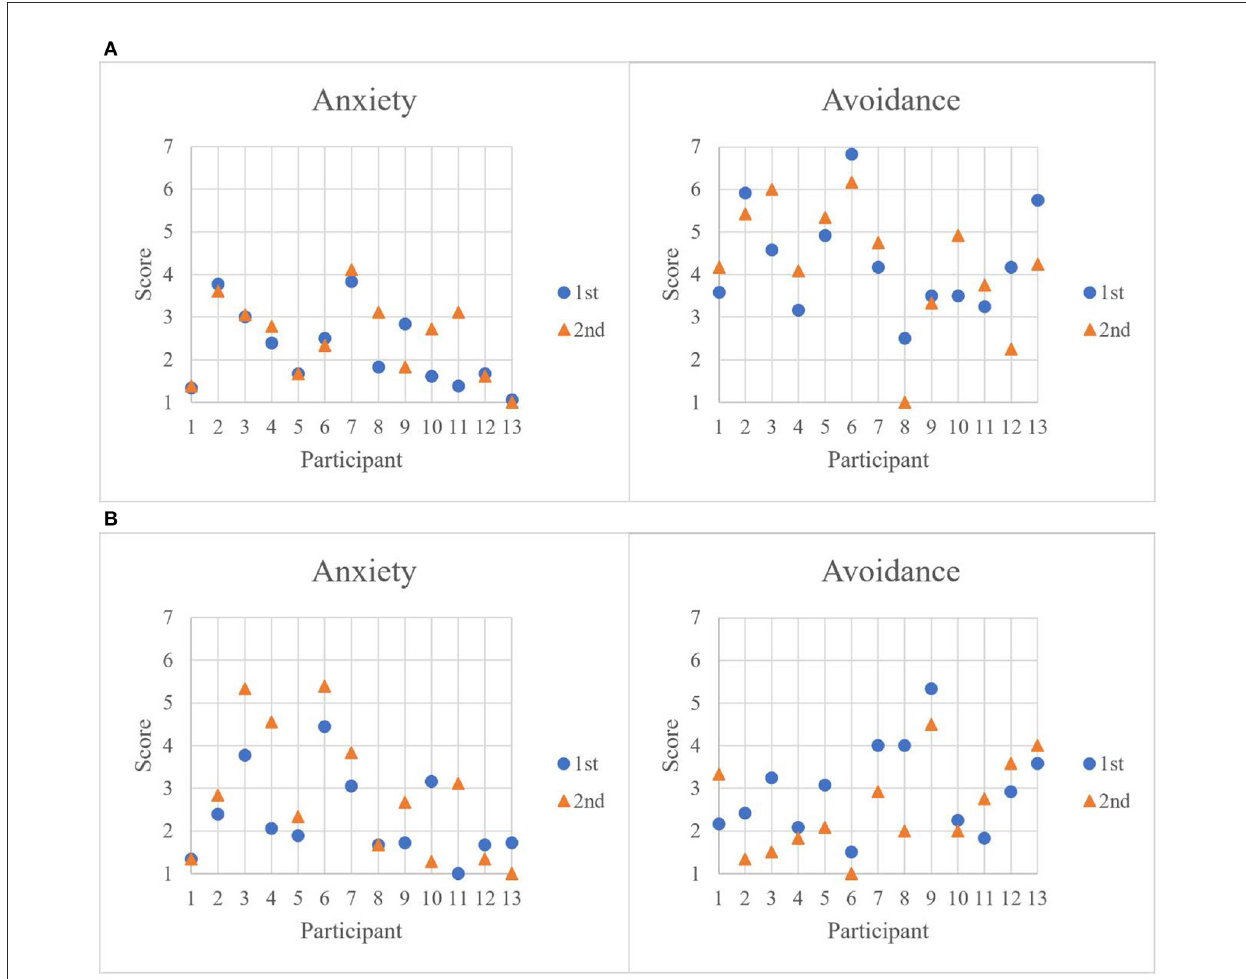
FIGURE3 (A) Results at the time the robot was taken away (1st) and 2 months after its removal (2nd), showing each participant’s differences concerning attachment-related anxiety and avoidance toward “humans.” Participants’ numbers correspond to their IDs [also used in (B) , Figures 4A, B]. (B) First and second measurement results, showing each participant’s differences concerning attachment-related anxiety and avoidance toward “robot.”